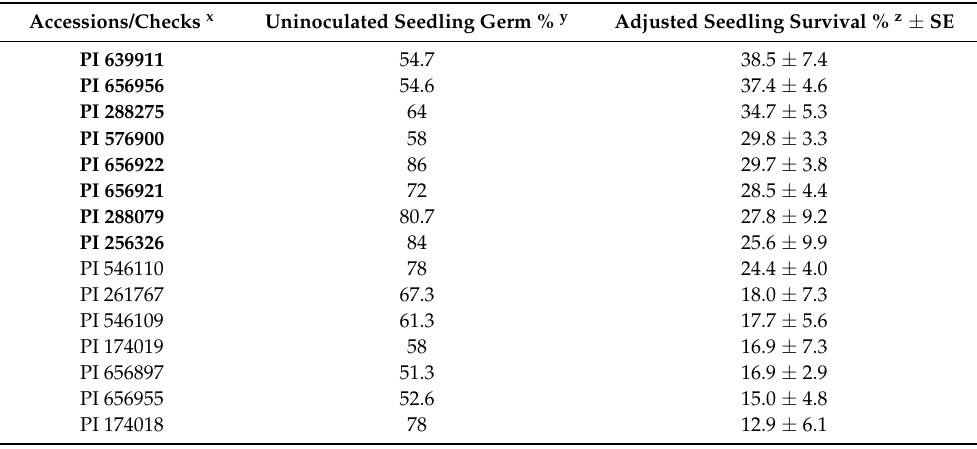
Table 1. Mean percent survival (in descending order) of USDA onion PI accessions evaluated in the seedling stage after inoculation with Fusarium oxysporum f. sp. cepae during